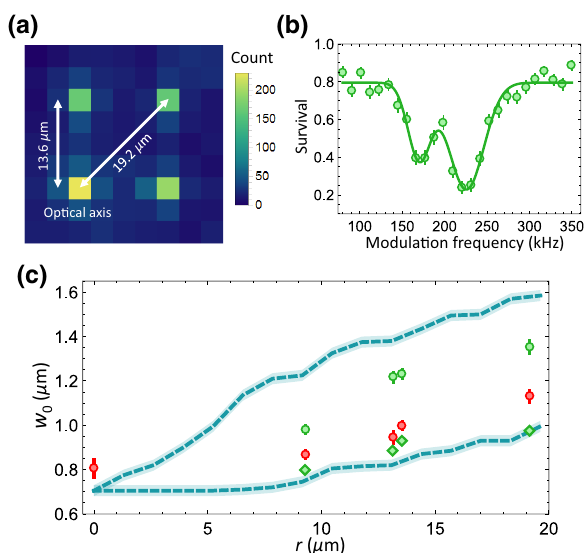
FIG. 3. The atom array and the metalens FOV. (a) A PGC fluorescence image of an atom array trapped with metasurface optical tweezers. The image is averaged over 100 experimen- tal cycles. The bottom-left tweezer is on the optical axis of the metalens. The off-axis tweezer sites typically have a lower load- ing probability and nonoptimal PGC imaging detuning, resulting in a dimmer single-atom signal. (b) An example of typical trap- frequency measurement data at approximately 13.6 μ m from the FOV center where asymmetric aberrations in the trap are present, along with a double Gaussian (green line) fit. (c) The extracted Gaussian waist as determined from the atom trapping as a func- tion of the distance ( r ) to the metalens optical axis (the center of the FOV). The average waist is extracted from a single Gaussian fit to the trap-frequency data (red) and the major waist (green circle) and minor waist (green diamond) are extracted from data similar to (b) when the two trap frequencies are distinguishable. We compare with the theory of the major and minor Gaussian waists fitted from FDTD simulation [see Fig. 4(c)]. [The error bars in (b) represent the standard deviation and the error bars in (c) are the standard